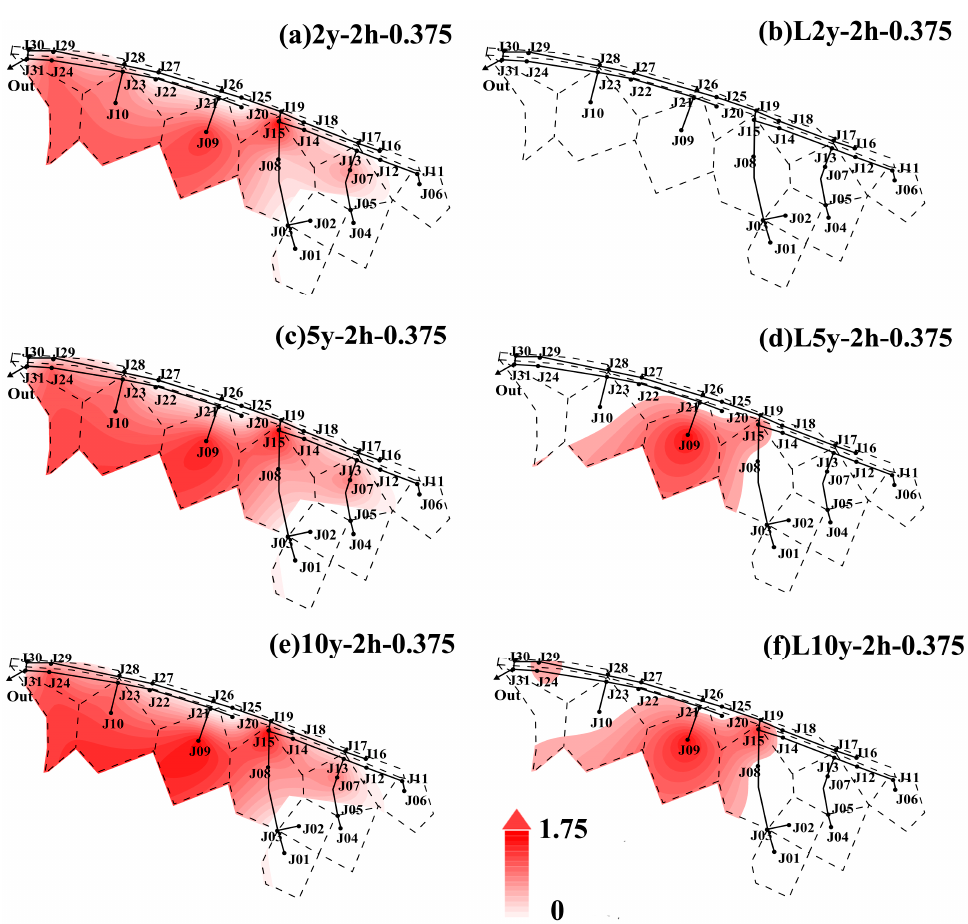
Figure 3. Impact of changes in rainfall intensity on flooding and LID practices. Characteristics of flooding spatial change are reflected by the projection value. ( a , c , e ) show where LID practices are not taken; ( b , d , f ) show where LID practices are taken.